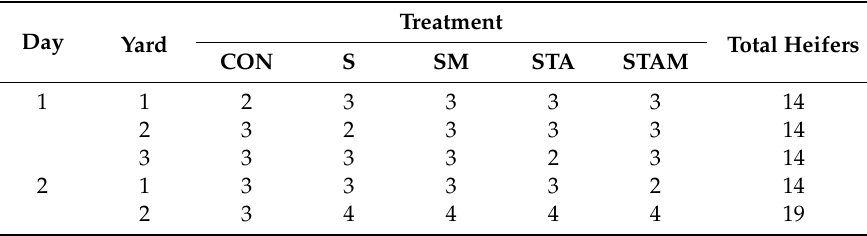
Table 1. Number of heifers in each treatment group by